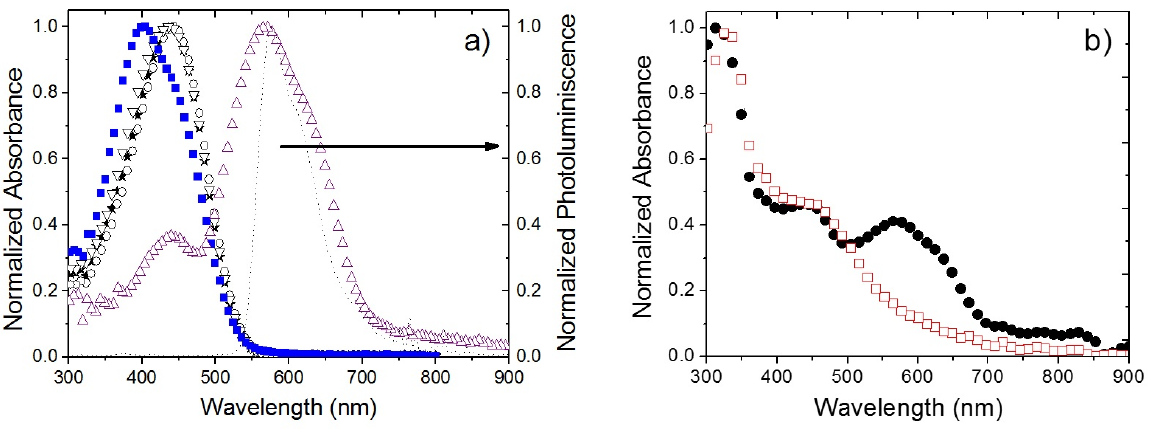
Figure 3. ( a ) Normalized absorption spectra of polythiophene derivative P1 (stars), P2 (inverted triangles), P3 (circles), P4 (squares), and M1 molecule (upright triangles), photoluminescence emission from P1 (dashed line), all spectra were acquired in solution; ( b ) Normalized absorption spectra in solid state of P1:PC 61 BM mixture (1:2 by weight) (open squares) and P1:PC 61 BM:M1 mixture (1:2:1 by weight) (filled